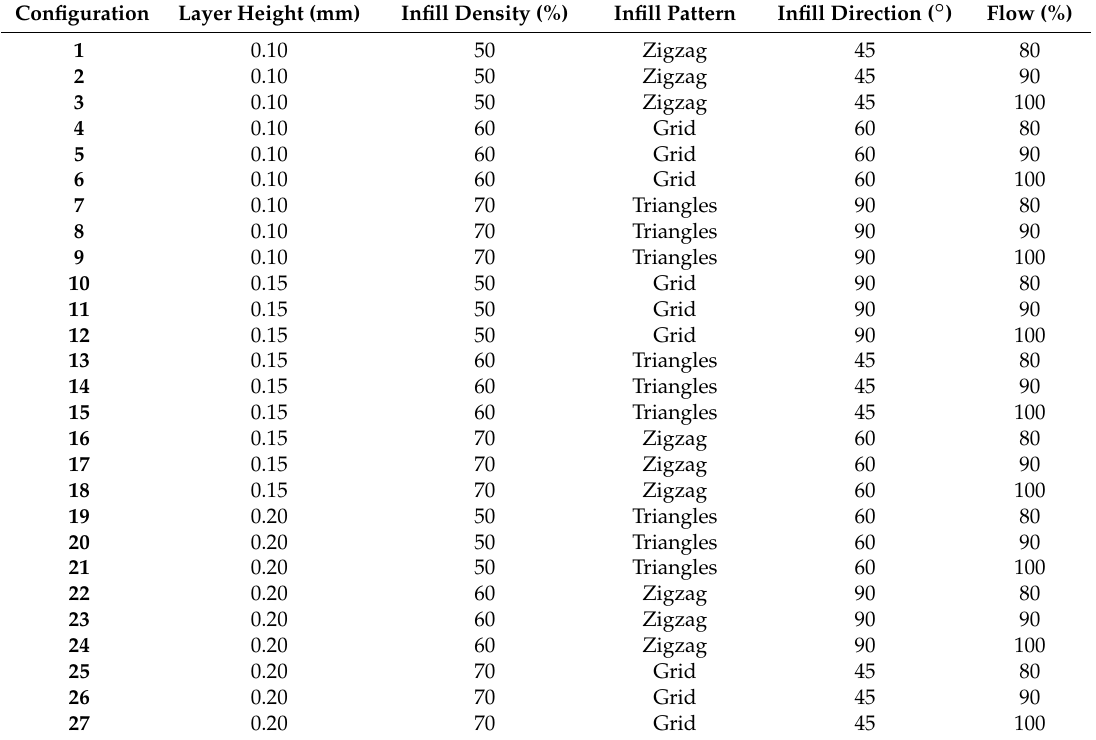
Table 1. Design and process parameters of PLA scaffold configurations resulting from Taguchi experimental